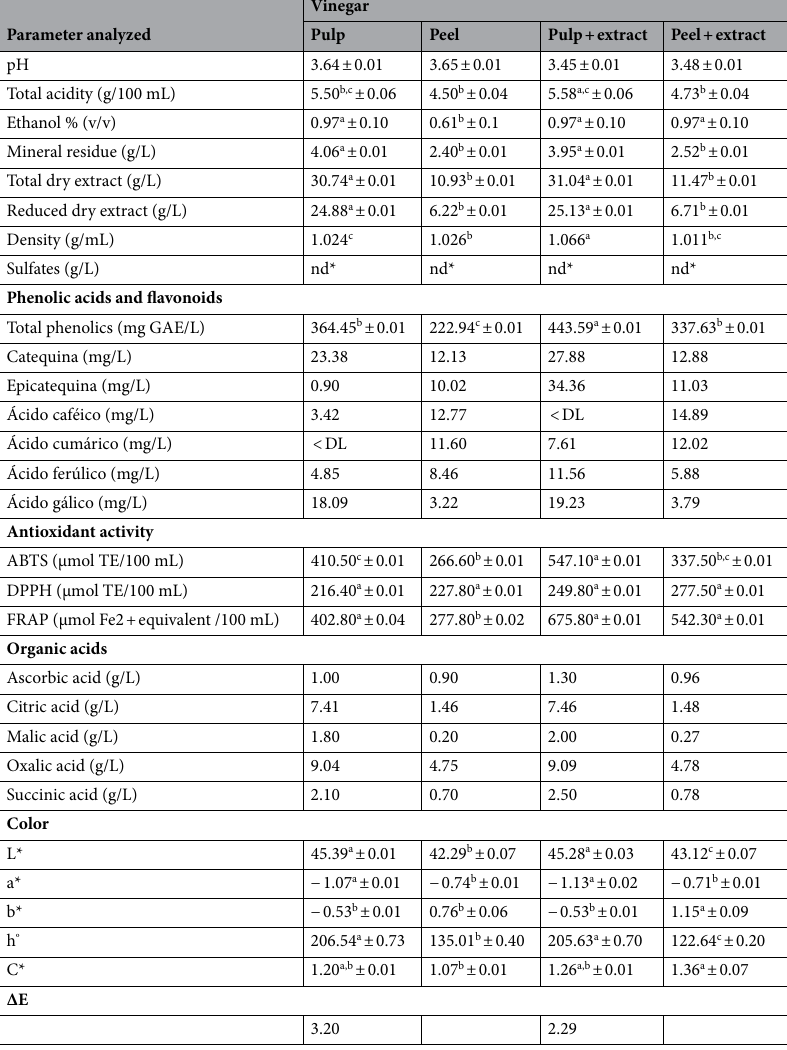
Table 4. Physicochemical and bioactive parameters of pineapple pulp and peel vinegar. Different letters on the same line differ statistically at the 95% confidence interval ( p <